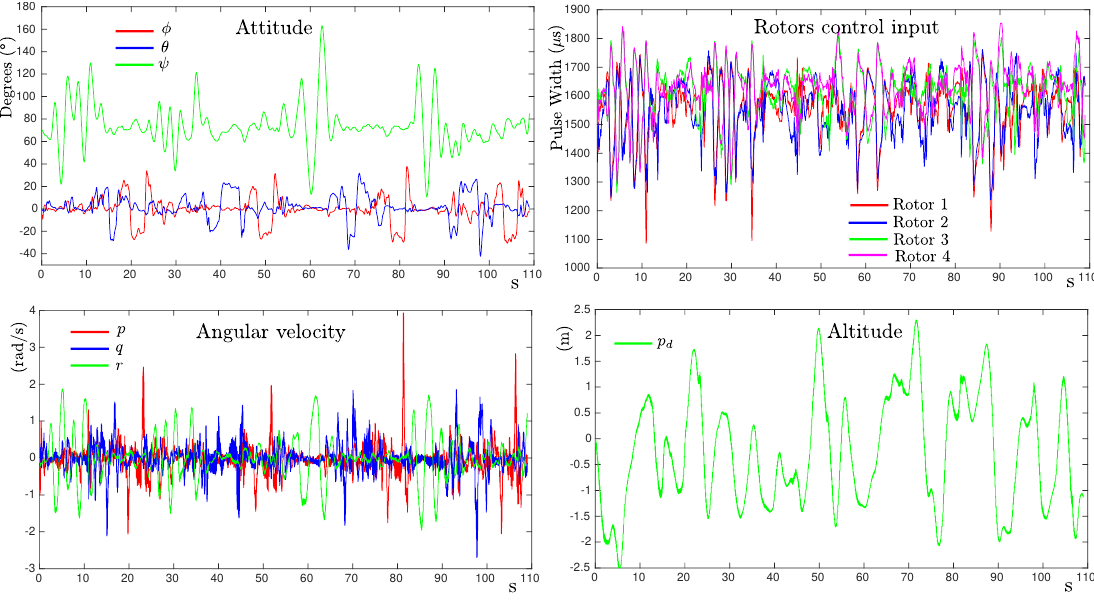
Figure 8. Flight log data used to estimate the model parameters ( J x , J y , J z , b , k )